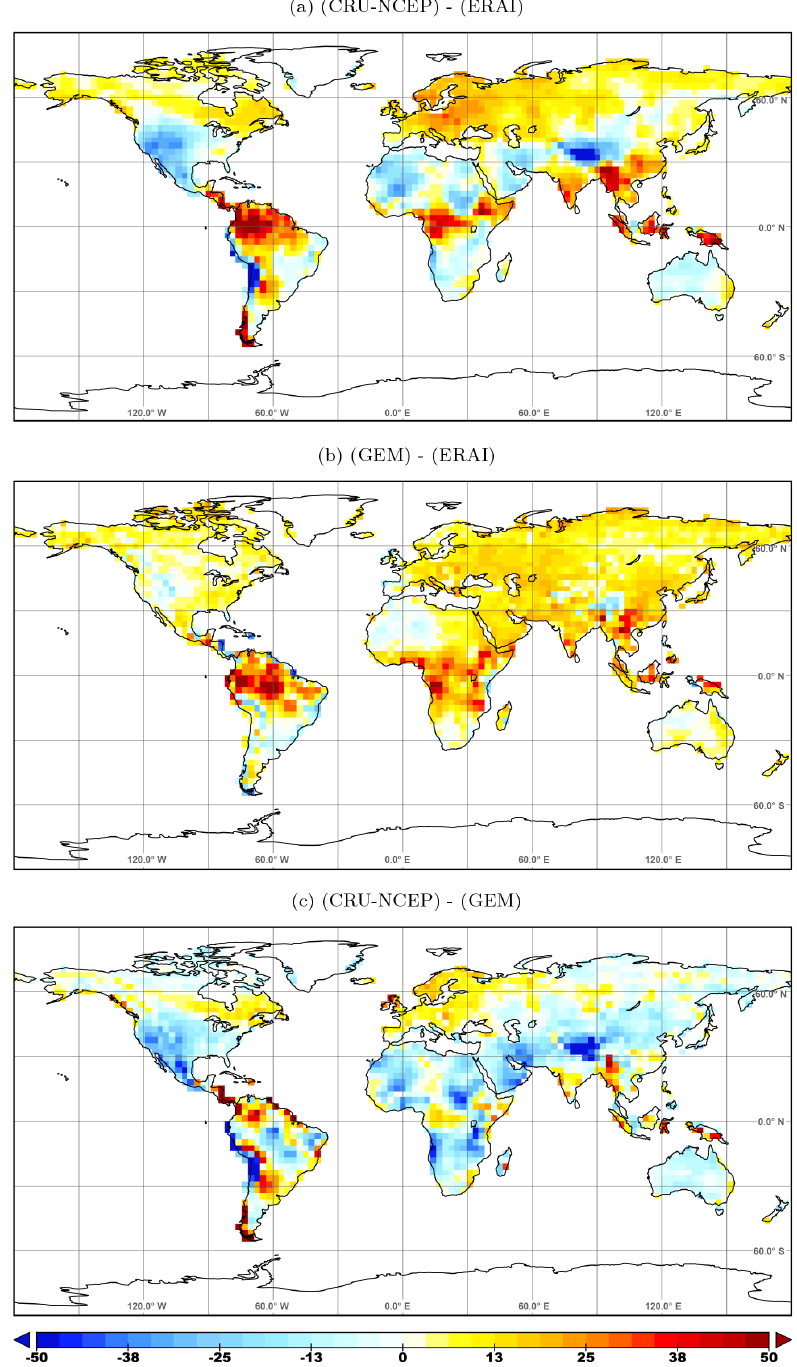
Figure 3. Comparison of spatial distribution patterns of annual mean shortwave radiation (Wm − 2 ) (averaged over the period 2009–2010): (a) CRU-NCEP minus ERAI, (b) GEM minus ERAI, and (c) CRU-NCEP minus